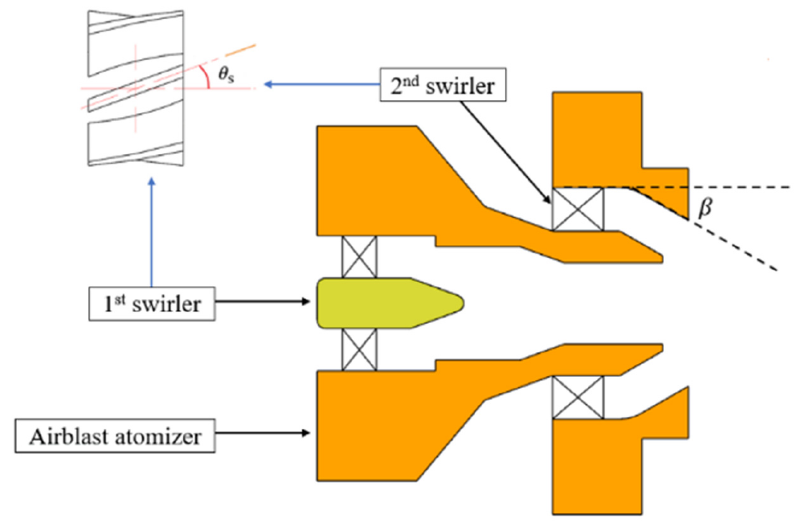
Figure 1. Schematic illustration of the two-stage swirler. The swirling flow with swirl number greater than 0.6 is usually defined as strong swirling flow, and it is usually used to form a primary recirculation zone [16]. The definition of swirl number is shown in Equation (1) [17]: